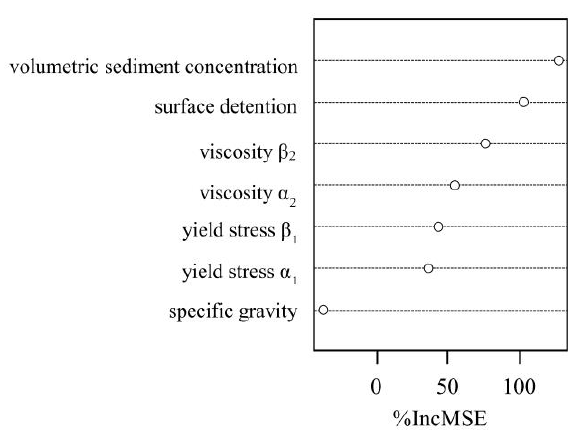
Figure 8. The results of the random forest analysis ranks model input factors based on importance.